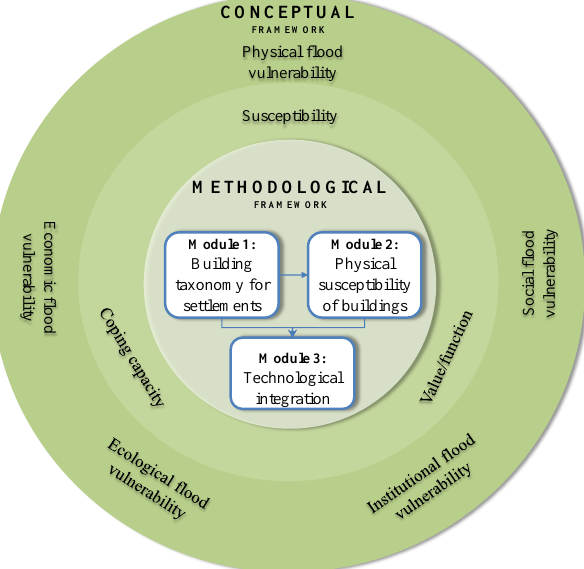
Figure 1. Frameworks of the methodology with dimensions of sus- tainability (outer circle), components of vulnerability (middle cir- cle) and the modules (inner